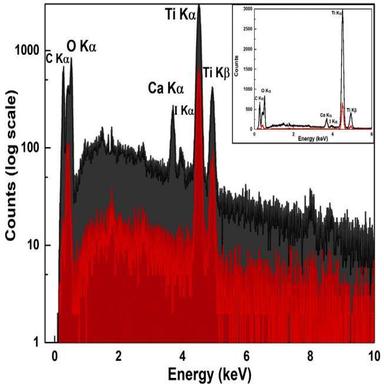
SEM image of self supporting Ti film fabricated by using CaI2 as a parting agent. The marked colors correspond respectively to the EDS spectra shown in in the same colors.